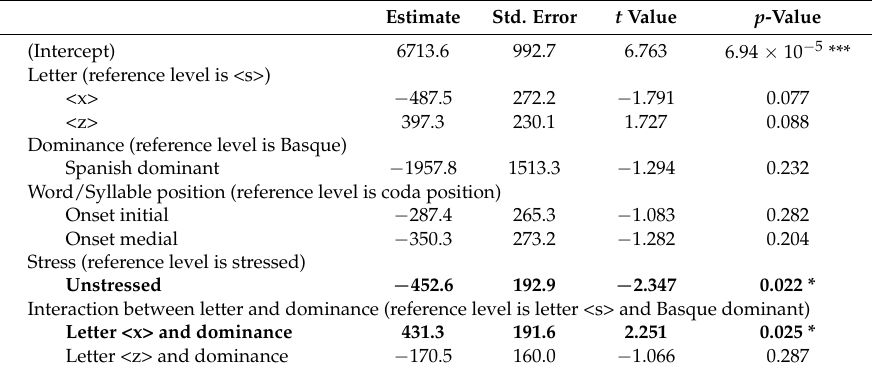
Table 4. Estimate, standard error, t value, and p -value of the best fit model in the mixed-effects regression modeling.